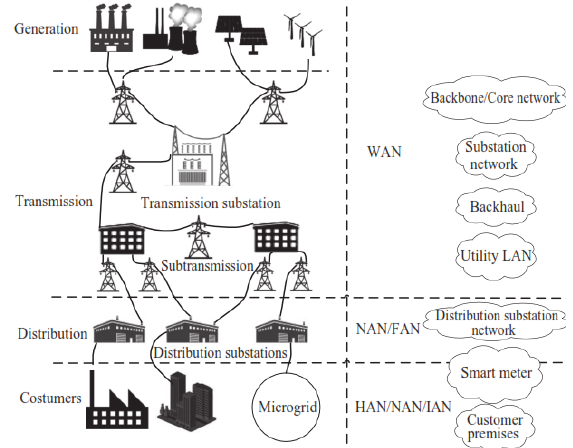
Figure 3 . Positioning of micro-grid at consumer side in smart grid with different levels of networking [9].